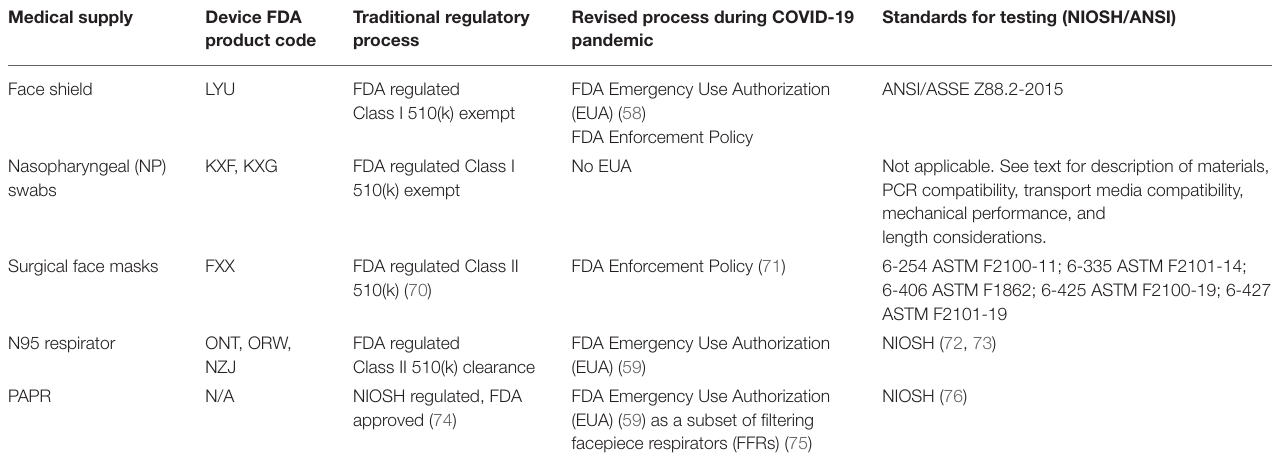
TABLE 2 | Summary of regulatory and testing standard for each device. Medical